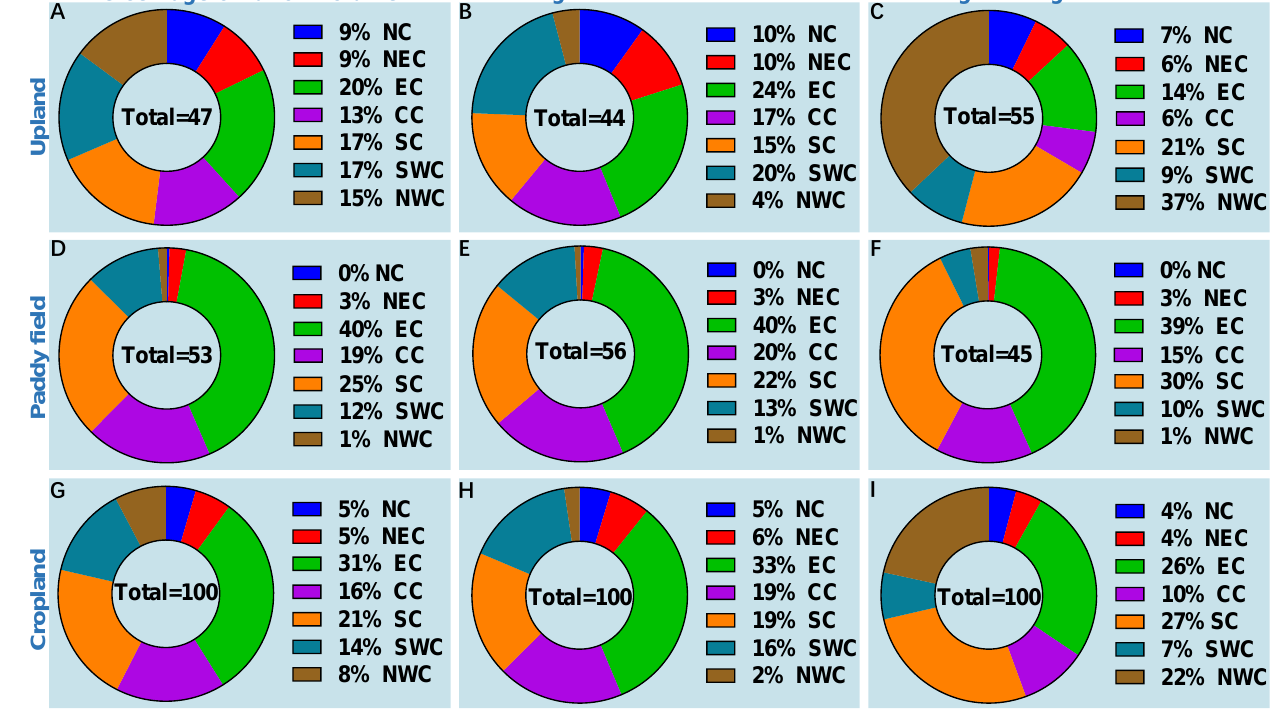
Figure 4. Contribution percentage of cropland ( A , D , G ) runoff volume, ( B , E , H ) rainfall-runoff volume, and ( C , F , I ) irrigation-runoff volume from the seven geographical regions (see Figure 3 for locations) to the total runoff of China.